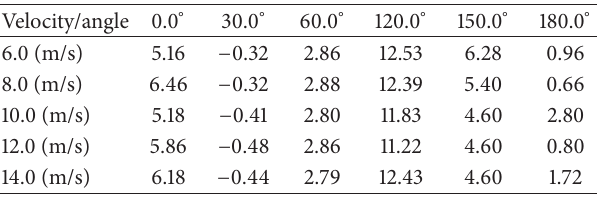
Table 4: Percentage wind load reduction. Negative sign indicates increase in